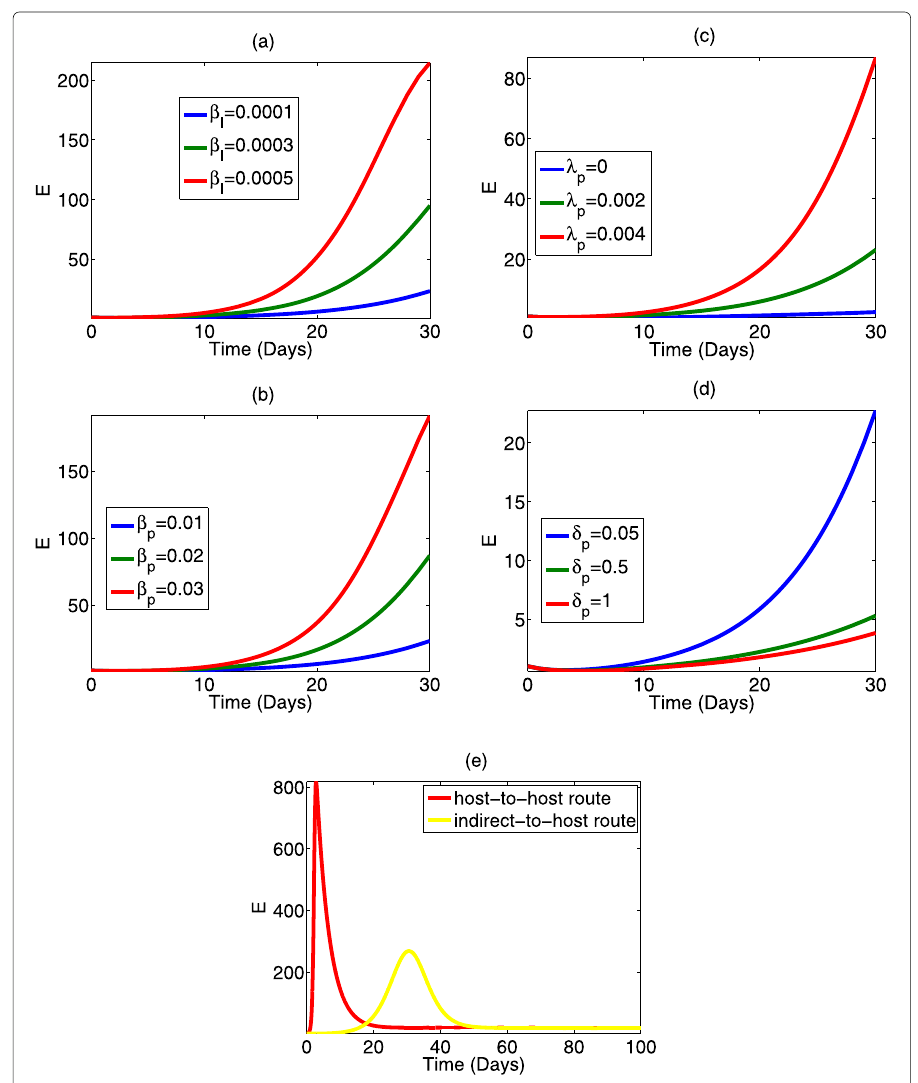
Fig. 1 a – e Variation of E with time for different values of the parameters β I , β p , δ p and λ p . In e β I = 0.05 and = 0.05. Other parameter values are in Table (1) β p